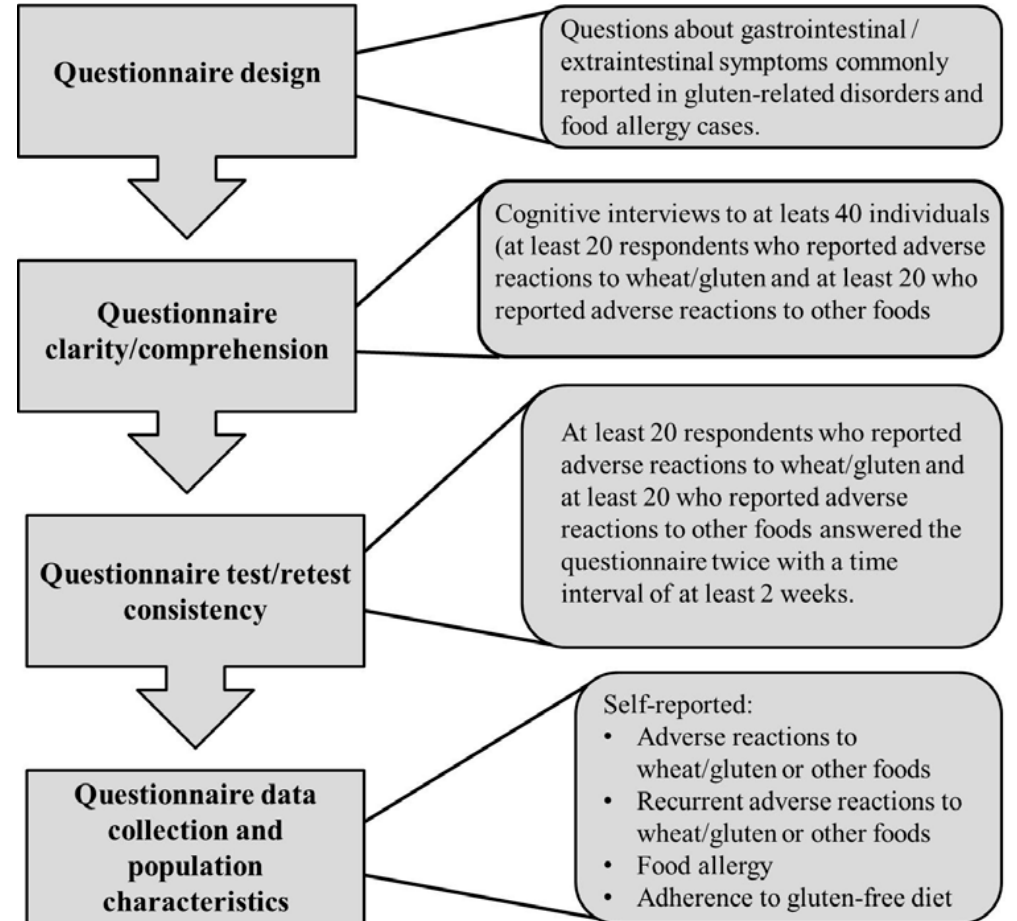
Figure 1. Flowchart of the study protocol.